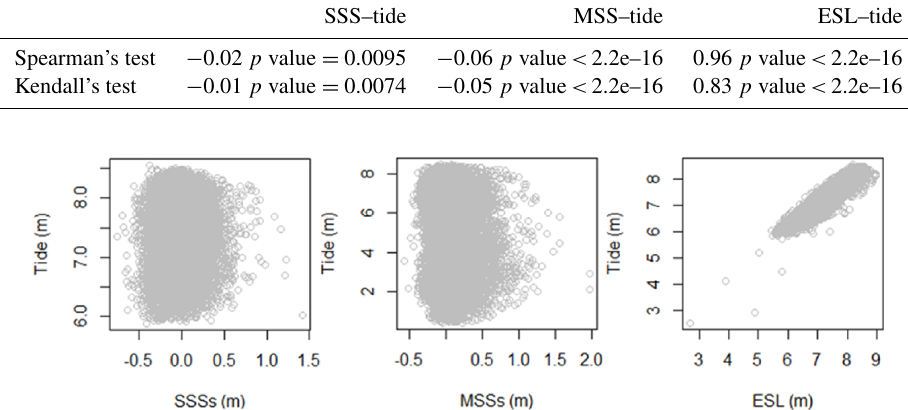
Figure 7. Analysis of the dependence between the tide and the SSSs, the MSSs and the ESL events.